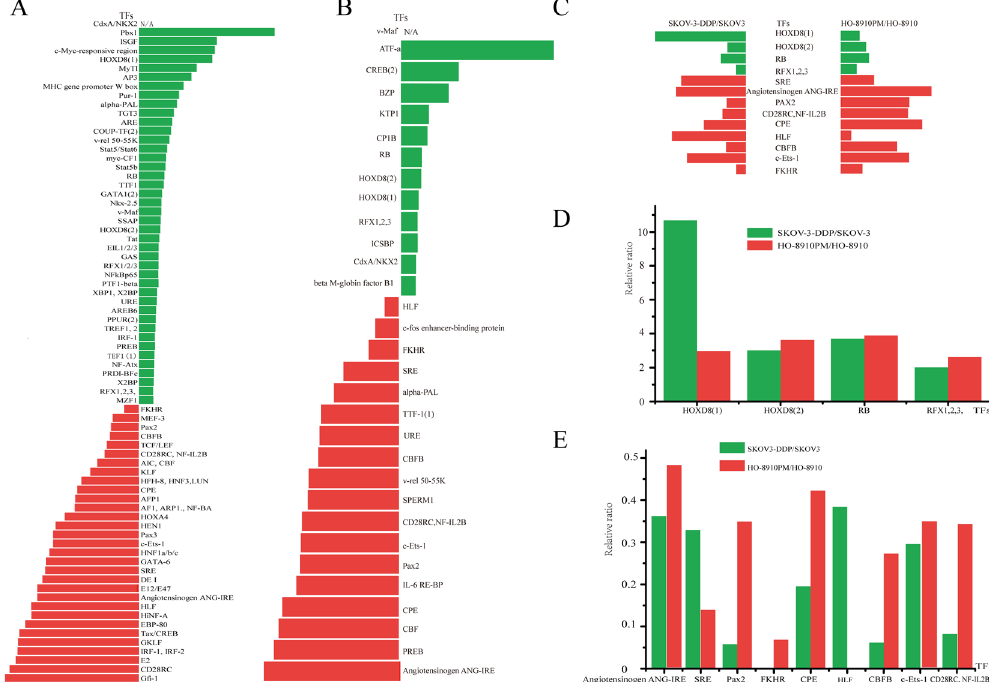
Figure 3. Analysis of protein/DNA arrays. Using the expression in SKOV3 and HO-8910 cells as a benchmark, differential expression of transcription factors was observed in the SKOV3-DDP/SKOV3 or HO-8910PM/ HO-8910, increased or decreased by two-fold, respectively. Forty-three transcription factors were up-regulated (green) and thirty-one down-regulated (red) in SKOV3 and SKOV3-DDP cells ( A ). Thirteen transcription factors were up-regulated (green) and eighteen down-regulated (red) in HO-8910PM and HO-8910PM cells ( B ). In conclusion, four up-regulated (green), and nine down-regulated (red) transcription factors were associated with ovarian cancer cisplatin-resistance and metastasis ( C ). The concrete activities were shown ( D , E ).